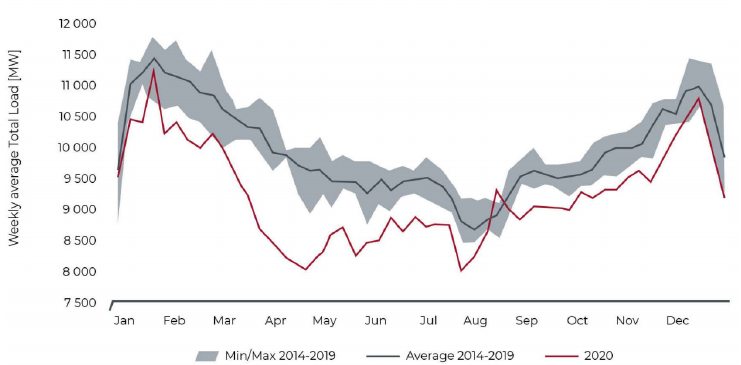
Figure 27. Weekly average total load in 2020 and previous five years in Belgium